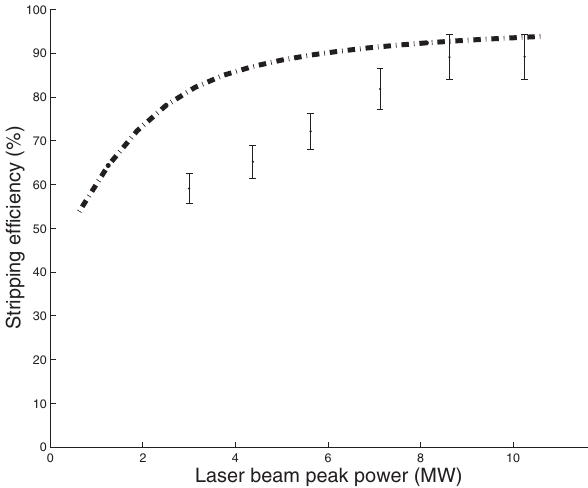
FIG. 5. Measured (dots with error bars), and calculated (dashed line) stripping efficiencies versus laser pulse peak power. The calculated efficiency reaches 99% for 20 MW laser peak